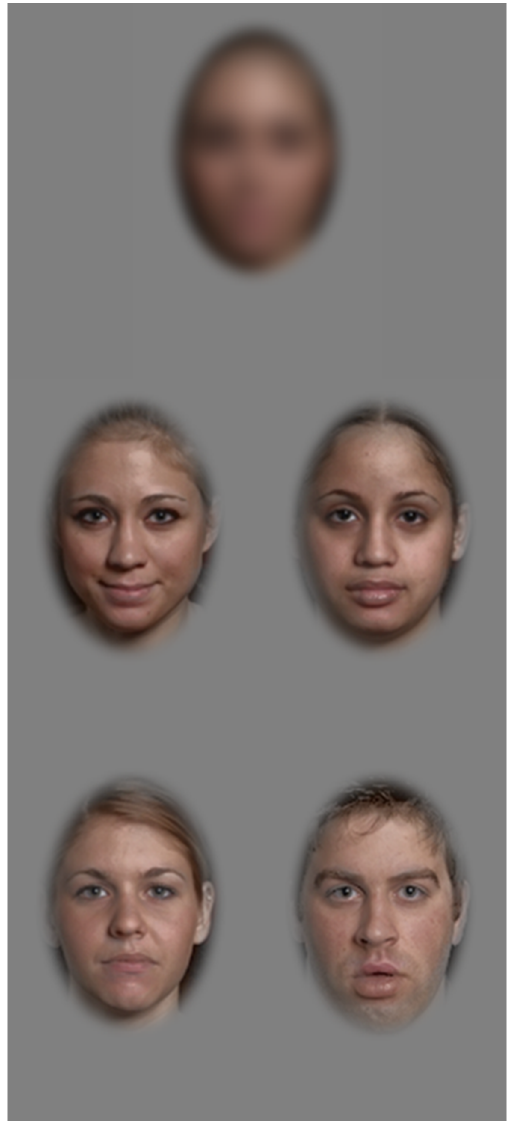
Figure 1. Example stimuli from the face recognition task. The top center image shows a blurred image ( σ = 13.6 pixels in this example) of the target individual. One of the lower 4 unblurred faces (chosen at random across trials) was a different image of the target individual, the other 3 faces were different individuals. Participants identified, using mouse click or screen touch, which of the lower 4 faces was the same individual as the top blurred face, guessing if necessary.